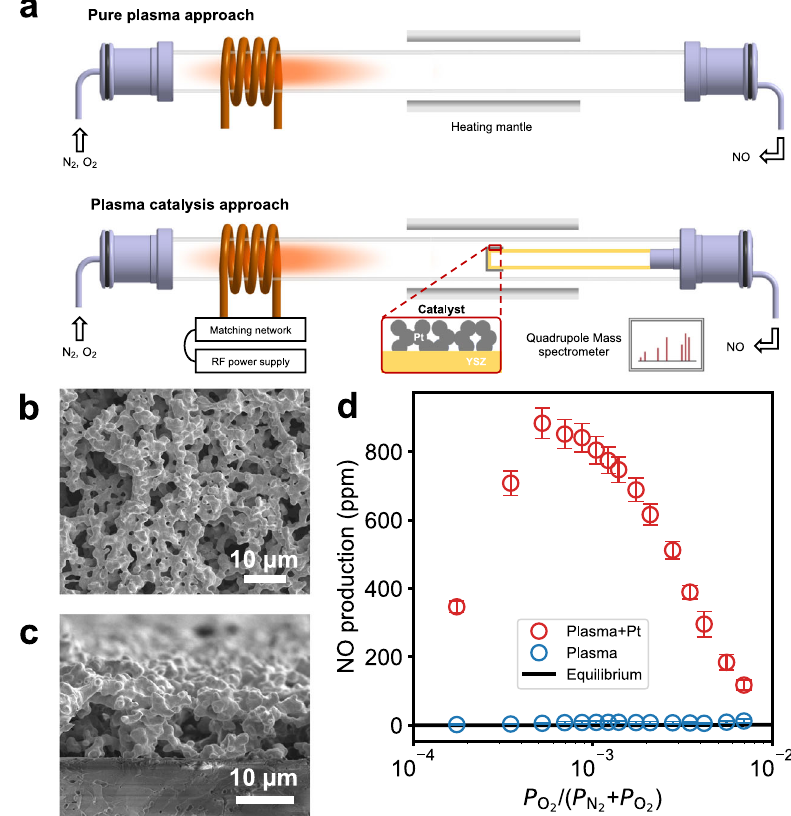
Fig. 1 Plasma-catalytic N 2 oxidation experiments. a Schematic representation of the plasma reactor setup in a plasma-only con fi guration (top) and plasma catalytic mode (bottom). In the catalytic mode, a porous Pt fi lm is coated on the end of a non-porous, capped yttria-stabilized zirconia (YSZ) tube. SEM images of ( b ) surface and ( c ) cross-sectional micrographs of porous Pt fi lm deposited on YSZ substrate. d Steady-state NO production from N 2 and O 2 radio frequency postdischarge at 873 K with low O 2 pressures. The error bars represent the standard deviation of at least three